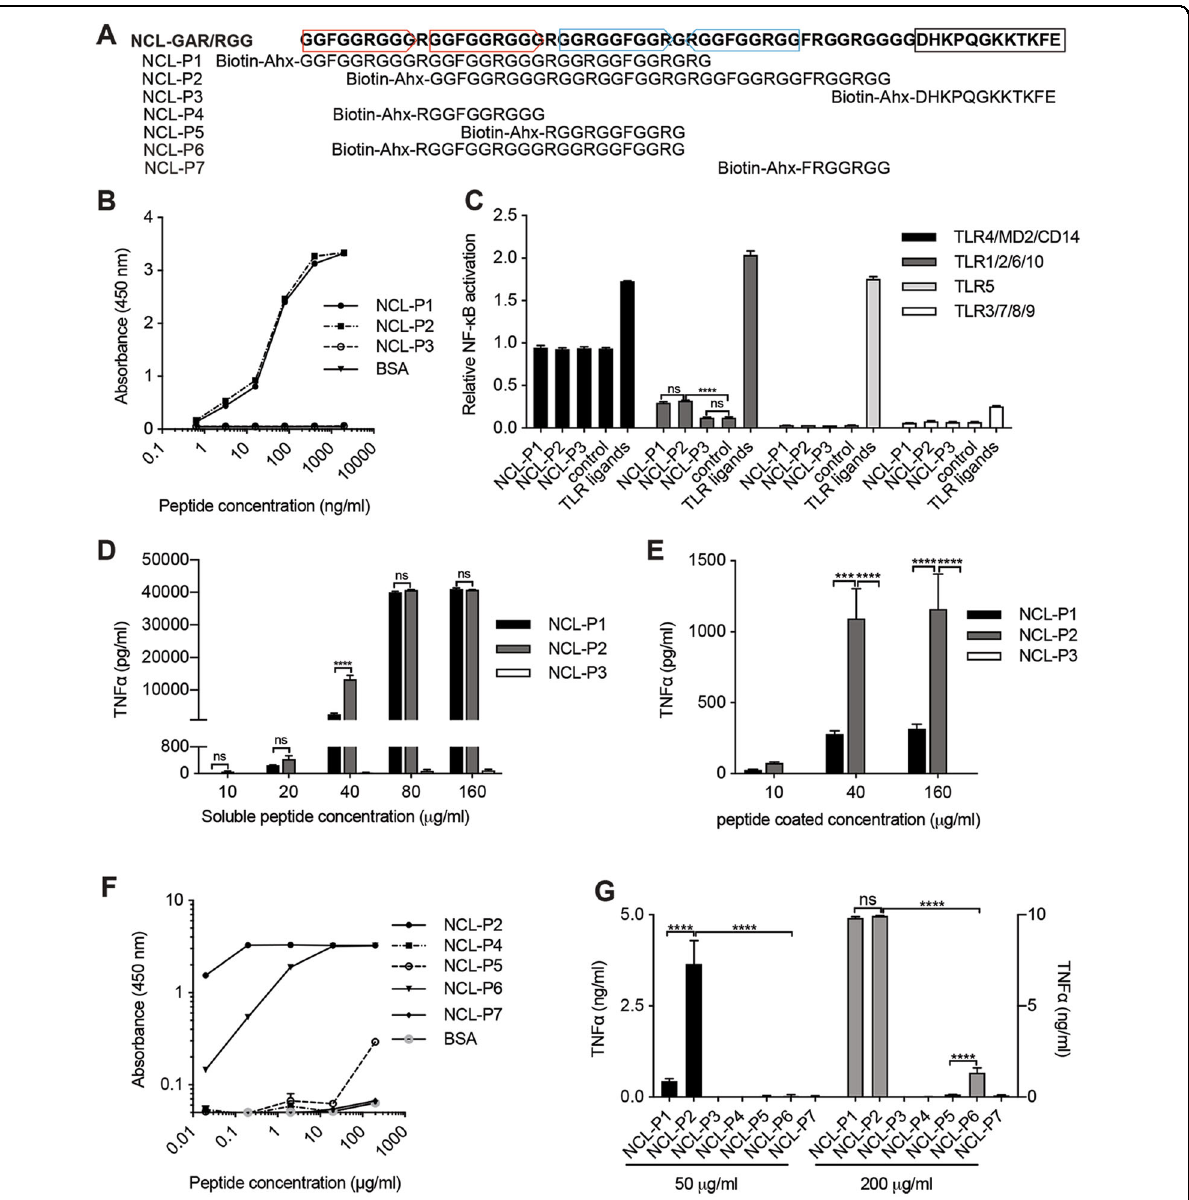
Fig. 4 NCL GAR/RGG peptides bind to TLR2 and activate monocytes. A Peptides were synthesized with N-terminal biotin-Ahx: six peptides corresponded to the GAR/RGG motif and one peptide represented the NCL C-terminal tail (NCL-P3). B TLR2 was coated (2 μ g/ml) to incubate with NCL-P1, NCL-P2 or NCL-P3 and bound peptides were detected using streptavidin-HRP. C In 293T cells, TLR4/CD14/MD2, TLR2/1/6/10, TLR5 or TLR3/7/ 8/9 were co-expressed with the fi re fl y and Renilla luciferase reporters. After 24 h, cells were stimulated with soluble NCL peptides (200 μ g/ml). TLR activation was determined by measuring NF- κ B activation. TLR ligands: LPS (TLR4, 0.5 μ g/ml), LTA (TLR2, 10 μ g/ml), fl agellin (TLR5, 1 μ g/ml), and PolyI: C (TLR3, 50 μ g/ml). D Monocytes were stimulated with the NCL peptides and TNF α production was measured by ELISA. E Peptides were coated at 10, 40, or 160 μ g/ml to stimulate monocytes and TNF α production was measured by ELISA. F TLR2 was coated (2 μ g/ml) to incubate with NCL-P4, NCL- P5, NCL-P6, NCL-P7 for which NCL-P2 and BSA were used as controls. Bound peptides were detected using streptavidin-HRP. G Monocytes were stimulated with the NCL peptides (50 or 200 μ g/ml). TNF α production was measured by ELISA. Triplicate experiments were performed. Data were presented as mean ± SD and analyzed by one-way ANOVA. **** p < 0.0001. n.s. not signi fi